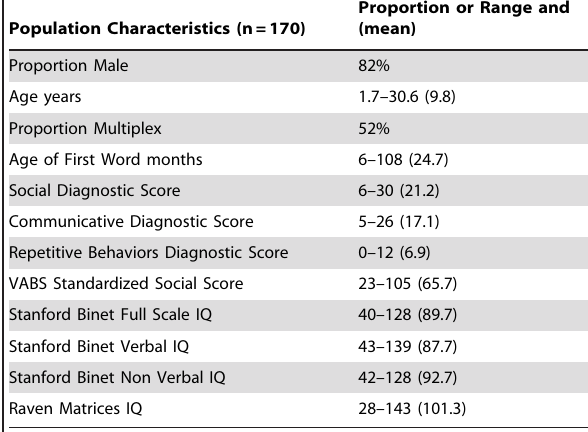
Proportion or Range and